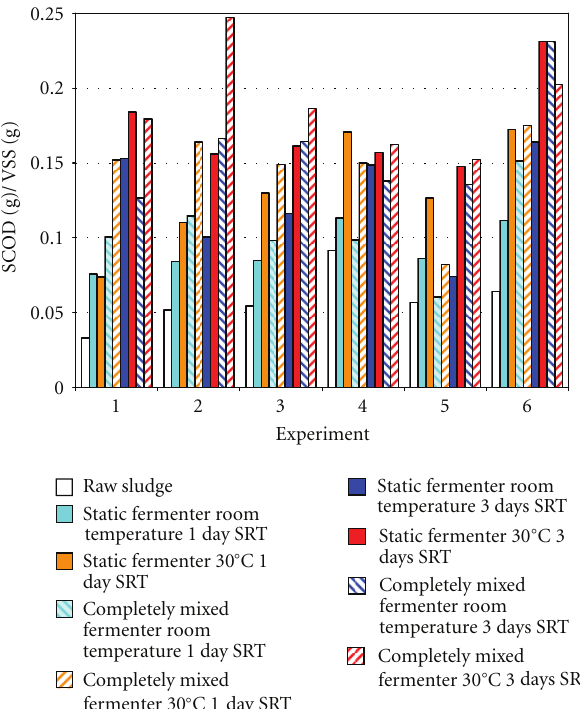
Figure 3: Specific SCOD production for each experiment.